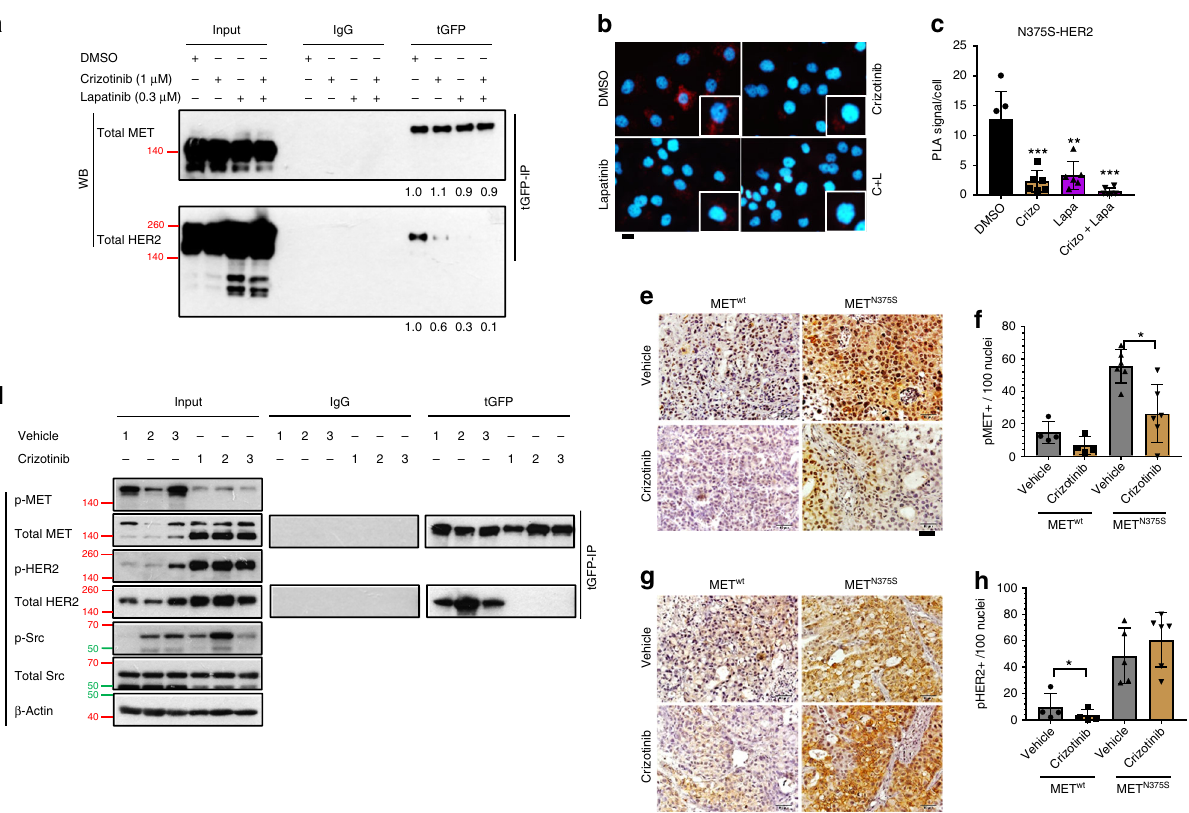
Fig. 5 Interplay between MET and HER2 requires kinase activities. a – c Isogenic H2170 MET N375S-tGFP cells were treated with vehicle (0.1% DMSO), MET inhibitor crizotinib (1 µ M), HER2 inhibitor lapatinib (0.3 µ M), or crizotinib/lapatinib combination. a Interaction of ectopic MET and endogenous HER2 was detected with immunoprecipitation and immunoblotting. Total MET and HER2 band intensities, relative to vehicle treated group, are shown below. Values represent average of three independent experiments. Left, input controls. b Detection of MET/HER2 co-localization (red) in MET N375S-tGFP cells with proximity ligation assay (PLA). Representative images are shown. Scale bar, 20 µ m. c The PLA signals were quanti fi ed and expressed as number of signals/cell ± SD ( n > 3). Crizo, crizotinib; Lapa, lapatinib. d MET/HER2 interaction in H2170 MET N375S-tGFP tumors from Supplementary Fig. 3J was detected with immunoprecipitation and immunoblotting after crizotinib treatment. Left, input controls. Cells were harvested 48 h after treatment, β -Actin was used as a loading control. e – h Immunohistochemistry staining of H2170 MET wt-tGFP and MET N375S-tGFP tumors from Supplementary Fig. 3J, K. Representative images for p-MET ( e ) and p-HER2 ( g ) staining are shown. Expression of p-MET ( f ) and p-HER2 ( h ) were quanti fi ed and expressed as mean of positive-staining/100 cells ± SD ( n = 5). Scale bar, 50 µ m. Two-tailed Student ’ s t test; * P <